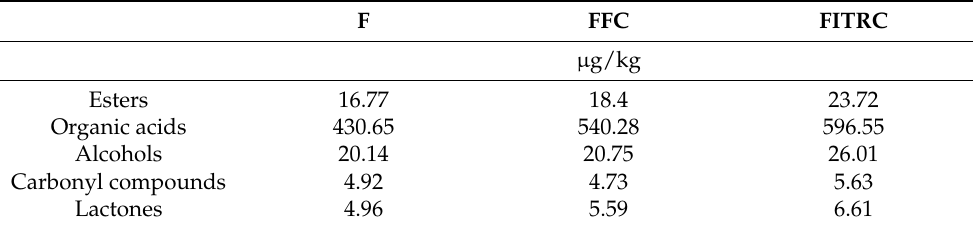
Table 4. Effect of free and immobilized L. paracasei SP5 on trahanas as starter culture on major aroma groups (mean values, µ g/kg of cheese) of white brined cheese after ripening for 70 d using the solid-phase microextraction (SPME) GC-MS